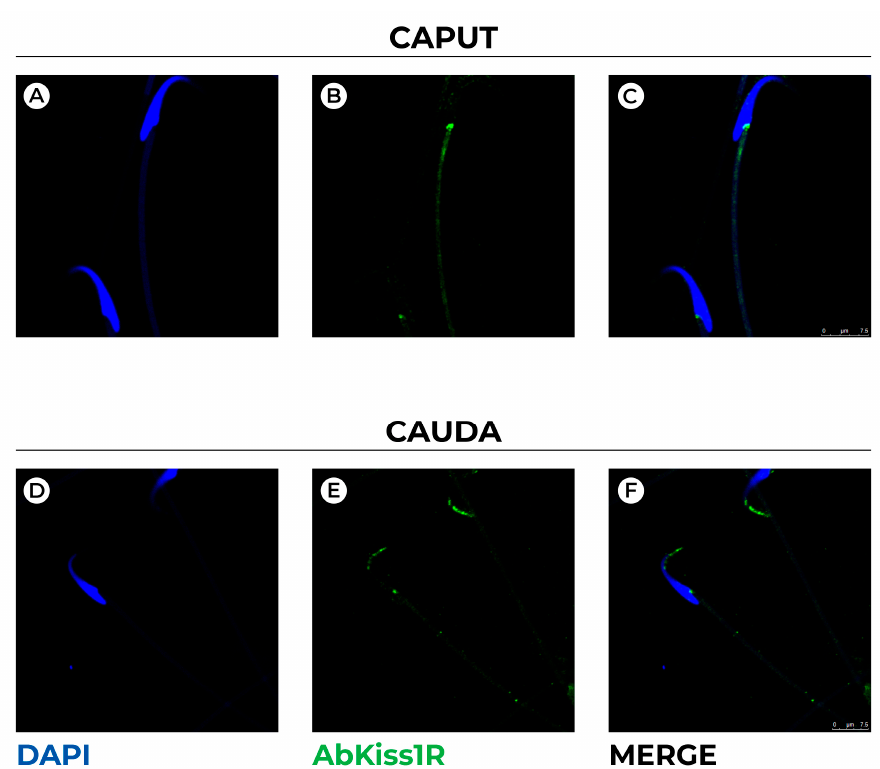
Figure 2. Confocal representative images showing immunofluorescence staining for Kiss1R (AbKiss1R, green) in rat spermatozoa collected from epididymis caput ( A–C ) and cauda ( D–E ). DAPI (blue) was used to counterstain sperm cell nuclei. Scale bar: 5 µm ( A–C ); 7.5 µm ( D–F ).